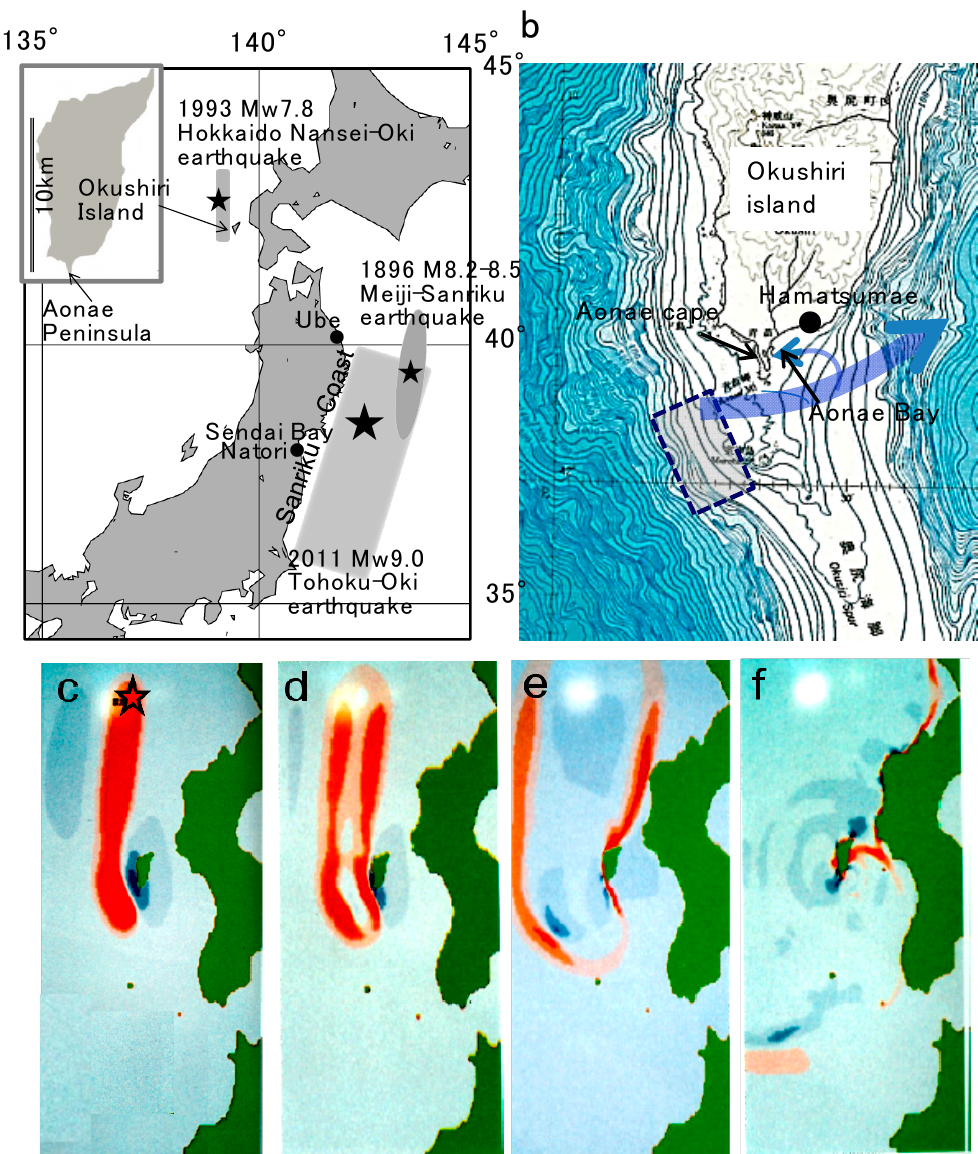
Figure 1. ( a ) Map showing the epicenter of the earthquakes where the tsunami-related fires occurred. Stars show the main shock epicenters. ( b ) Map of south area of Okushiri Island (created by the Japan Coast Guard). Arrows indicate the path of the first tsunami wave, a dotted square shows the survey area by the Japan Agency for Marine-Earth Science and Technology (JAMSTC). ( c – f ) Computer graphics of tsunami propagation: Immediately after the fault rupture, and 1, 4, and 12 min after the fault rupture, respectively [6], A star in (c) shows the epicenter. (courtesy of Tohoku University Disaster Control Center and Okushiri Town Hall).